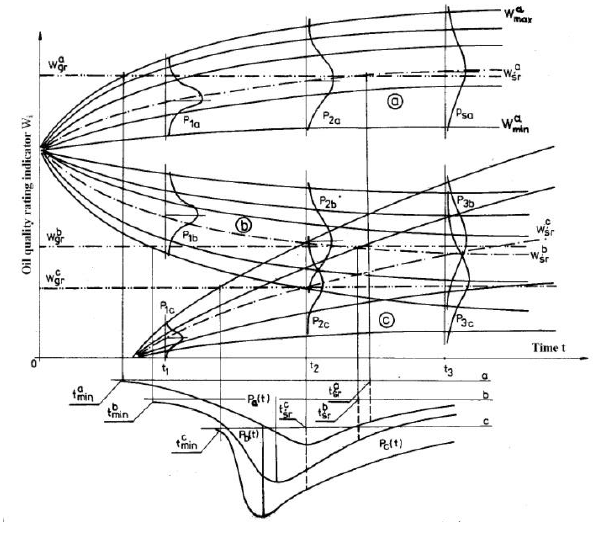
Fig. 1. Kinetics of changes in oil quality assessment indicators